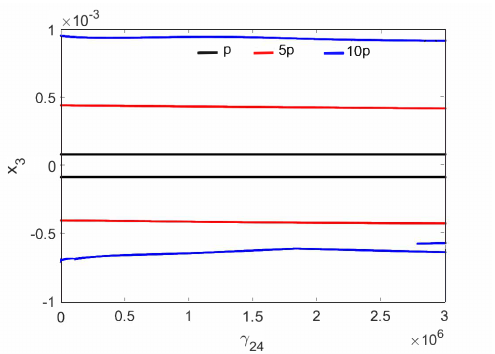
Figure 2. Bifurcation diagrams of the stapes in the normal ear at the first resonance versus the nonlinear stiffness of the coupler ( γ 24